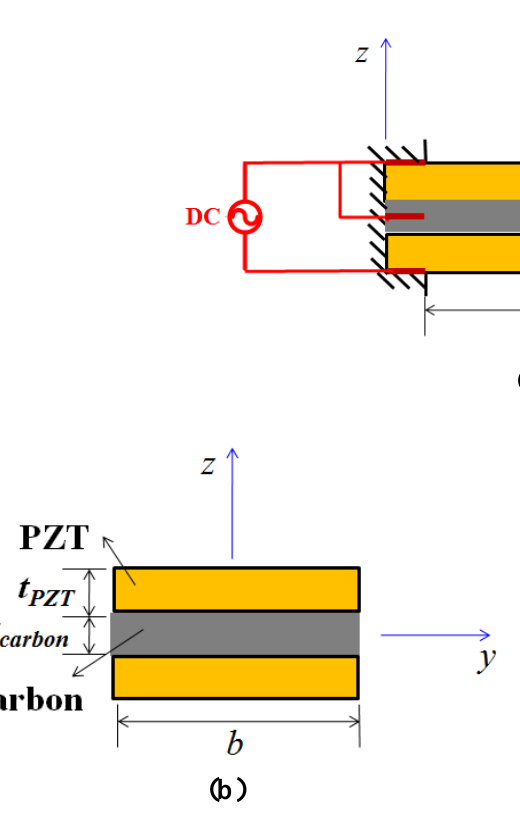
Figure 5. Structure variables of triple-layer bimorph actuator: (a) crosswise view; (b) cross-section view; (c) deflection skew and equivalent